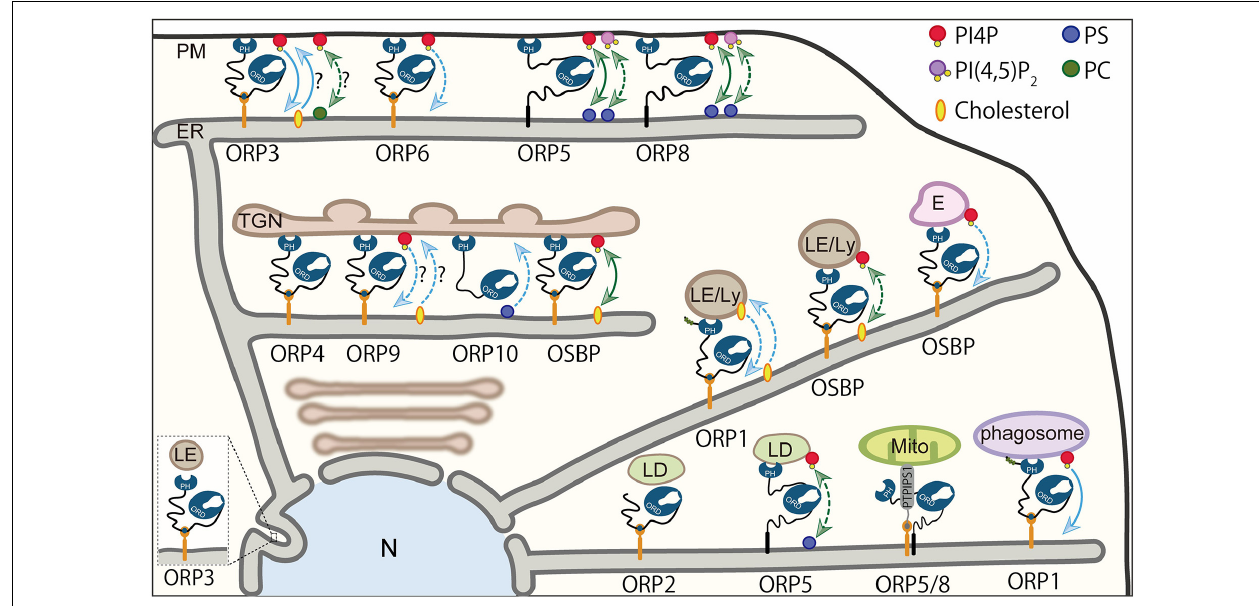
FIGURE 4 | Lipid transport/countertransport mediated by ORPs at MCSs. Summary of ORPs mediating transport or countertransport of lipids at MCSs. At the ER–PM MCSs, ORP5 and ORP8 mediate countertransport of PI4P and PS driven by PI4P metabolic cycle. They have been proposed to act as PI(4,5)P 2 /PS exchangers. ORP3 and possibly ORP6 mediate PI4P transport to the ER, while ORP3 may transport PC or cholesterol from the ER in exchange for PI4P. At the ER–Golgi MCSs, OSBP is an exchanger of PI4P and cholesterol. ORP10 has been suggested to mediate PS transport from the ER. The function of ORP4 and ORP9 as transporters/exchangers is unknown. At the MCSs between the ER and endosomes, late endosomes, or lysosomes, OSBP functions as a PI4P transporter or PI4P/cholesterol exchanger. ORP1 acts as a sensor or transporter of cholesterol and a transporter of PI4P. At the ER–lipid droplet (LD) MCSs, ORP5 has been proposed to be a PI4P/PS exchanger. The role of ORP2 as a transporter/exchanger at the ER–LD MCSs is unknown. At the ER–mitochondria MCSs, ORP5 and ORP8 may or may not be exchangers/transporters for PI4P and PS. Blue arrows indicate “transport,” whereas green arrows show “countertransport.” Solid lines are used if the transport or countertransport of the indicated lipids has been demonstrated by loss-of-function or gain-of-function analysis in an acute manner (e.g., acute inhibition or manipulation of ORP proteins). Dashed lines are used if the transport or countertransport of the indicated lipids has been suggested by loss-of-function or gain-of-function analysis in a chronic manner [e.g., chronic inhibition (knock-down or knock-out) or overexpression of ORP proteins]. ER, endoplasmic reticulum; E, endosomes; LE/Ly, late endosomes/lysosomes; Mito, mitochondria; N, nucleus; PM, plasma membrane; TGN, trans -Golgi